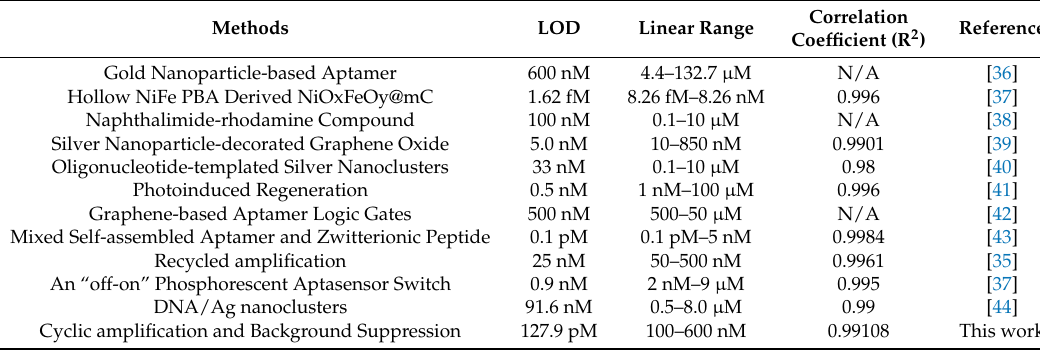
Figure 5. ( A ) Fluorescence spectra of the ATP detection at various concentrations using the DNA machine: 0 nM, 100 nM, 200 nM, 300 nM, 400 nM, 500 nM, 600 nM, 1000 nM, 2000 nM, and 3000 nM; ( B ) the ∆ F/F 0 values of the ATP concentrations from 0 to 3000 nM; ( C ) the ∆ F/F 0 values of the ATP concentrations from 100 to 600 nM. Table 3. Comparison of other methods used for ATP detection.